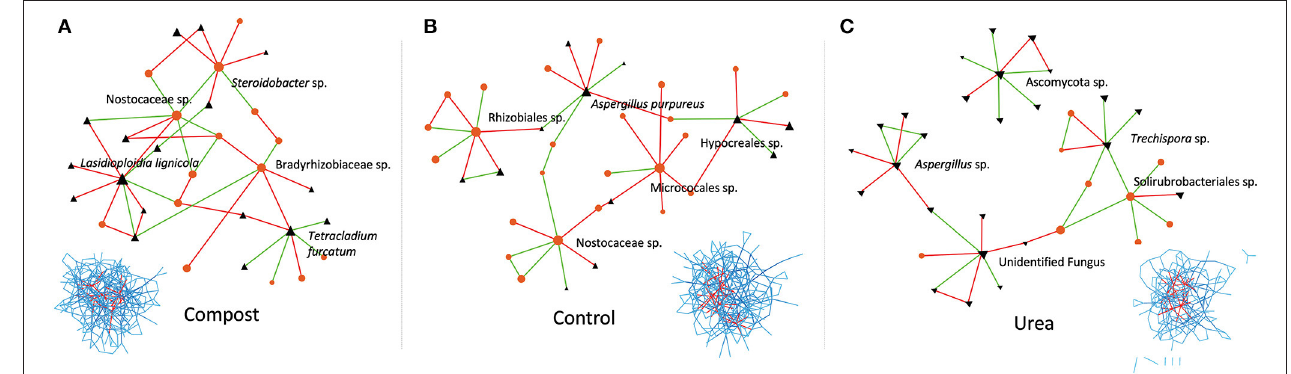
FIGURE 6 | Cross-domain subnetworks showing hub taxa and their interactions across (A) compost, (B) control, and (C) Urea. Bacterial nodes are represented by orange circles, and fungal nodes are represented by black triangles. Inset shows the location of the subnetworks (red) within the full cross-domain network (blue). Bacterial nodes are indicated by orange circles and fungal nodes are indicated by black triangles. Edges between nodes represented a positive association (green) or negative association